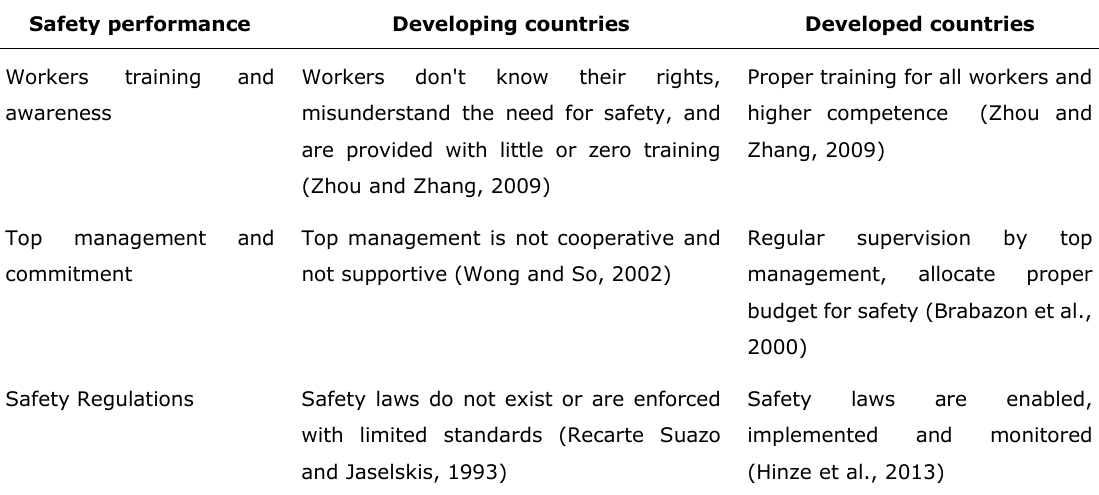
Table 2. Comparison of construction safety behaviour between developing and developed